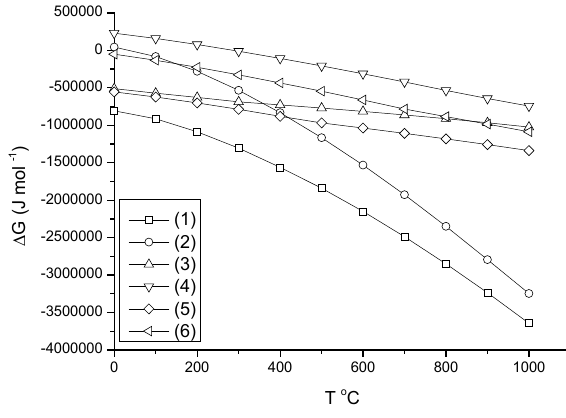
Figure 5: A comparison of the computed values of Gibbs energy (∆G o , J mol -1 ) against temperature (T, o C) for the roasting of ilmenite with different alkali salts , using the HSC 5.1 software [15].